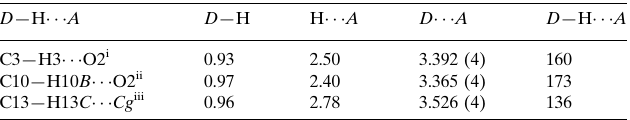
Hydrogen-bond geometry (A˚ , (cid:2)